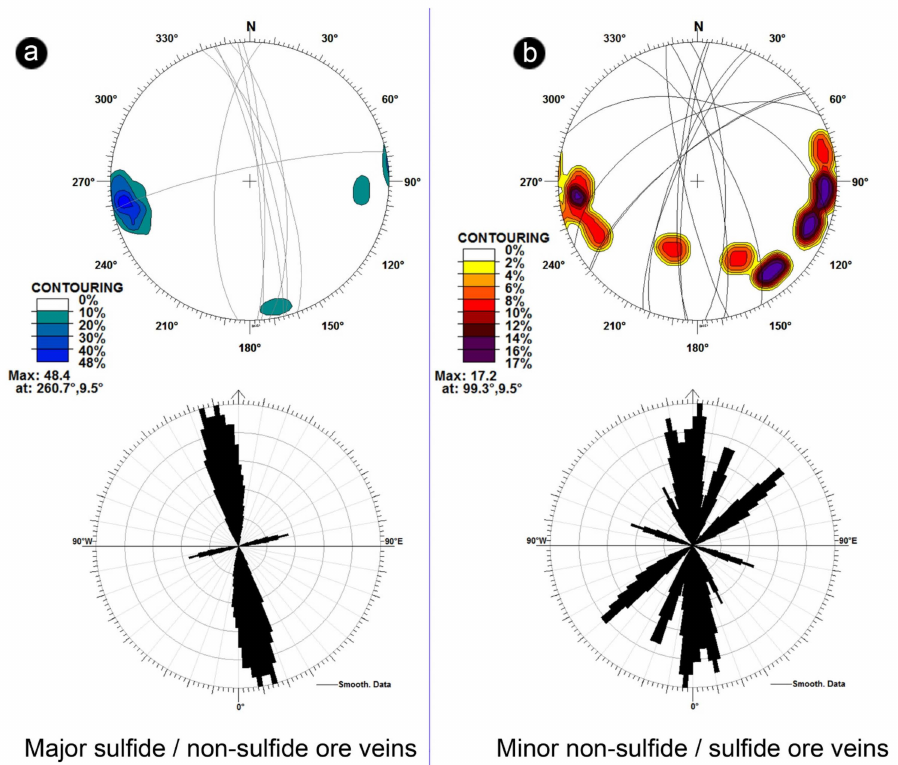
Figure 4. Stereographic projections and rose diagrams of the structural measurements of the major ( a ) and minor ( b ) ore veins in the Ab-Bid deposit. The lengths of the high-grade major ore veins are between 40 and 150 m, but those of the minor low-grade ore veins are less than 15 (1 to 15) m.